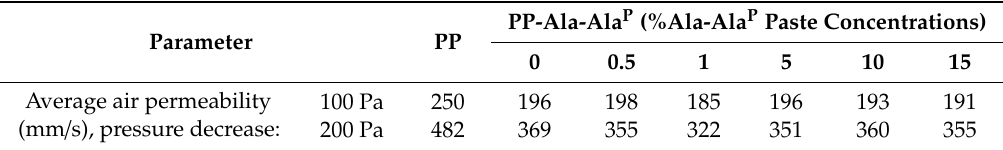
Table 6. The air flow resistance of polypropylene (PP) nonwovens without and with L-Ala-Ala P modifier according to: PN-EN ISO 9237:1998 [55].